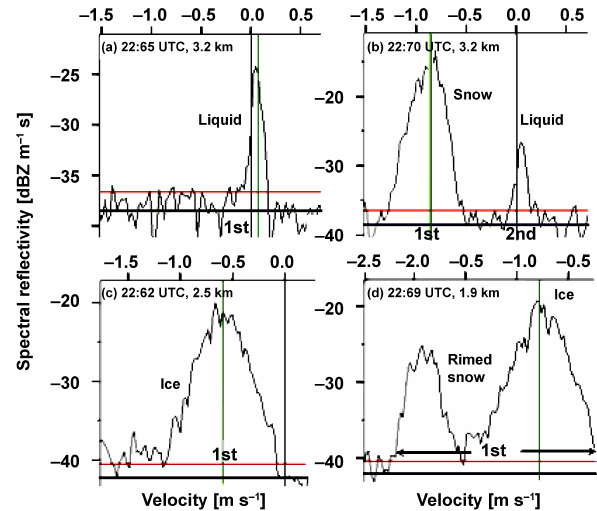
Figure 4. Examples of KAZR Doppler spectra at different times and heights. Notice the different x and y scales. Maximum and mean noise floor determined according to Hildebrand and Sekhon (1974) are indicated by grey and black horizontal lines, respectively. The primary peak is labeled as 1st, the secondary peak as 2nd. The mean Doppler velocity of primary peak is shown by the verti- cal grey line. The plots are created with the Doppler Spectrum Visualizer, a visualization toolkit which is publicly available at http://www.gim.bnl.gov/armclouds/specvis_java_toolkit/.